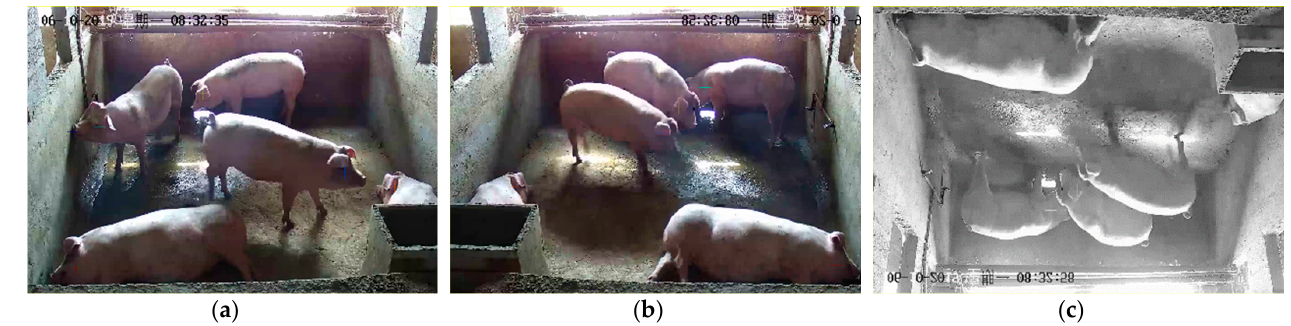
Figure 5. Sample preprocessing. ( a ) The labeled image; ( b ) image flip; ( c ) image rotation.